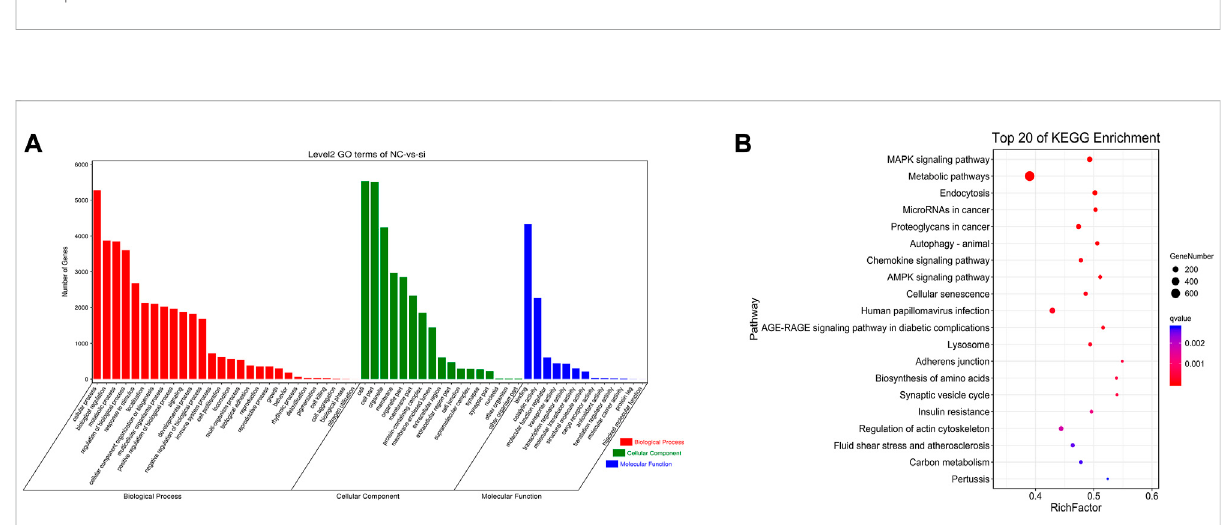
FIGURE 2 Statistical analysis of DE-miRNA. (A) The expression of miRNA volcano. The green dots on the left represent miRNAs that are signi fi cantly downregulated; the blue dots represent miRNAs that were not signi fi cantly different; and the red dots on the right represent miRNAs that were signi fi cantly upregulated. (B) Cluster map of differentially expressed miRNAs. Red indicates elevated expression and green indicates downregulated expression.